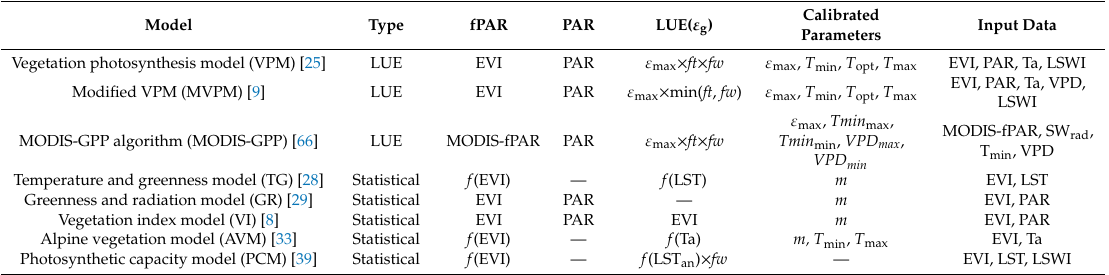
Table 1. Model structures and parameters of the eight satellite-based gross primary production (GPP) models. LUE, light use e ffi